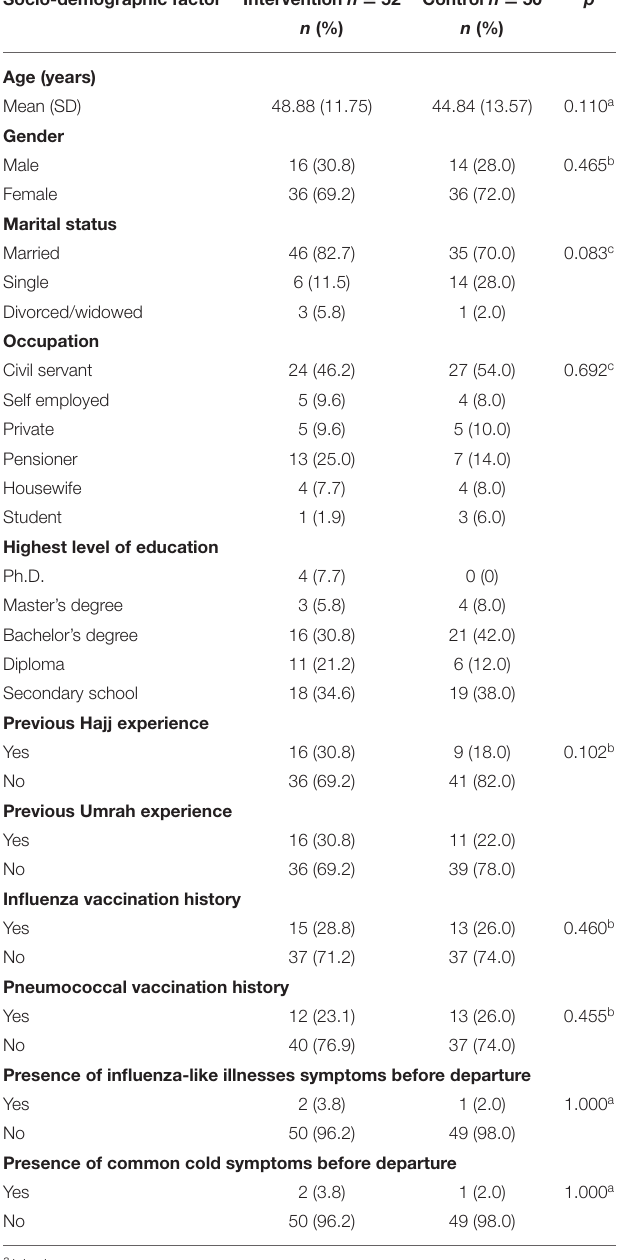
TABLE 1 | Socio-demographic characteristics of the respondents. TABLE 2 | Comparison of KAP scores of RTI prevention during Hajj/Umrah within each group based on time (time effect).